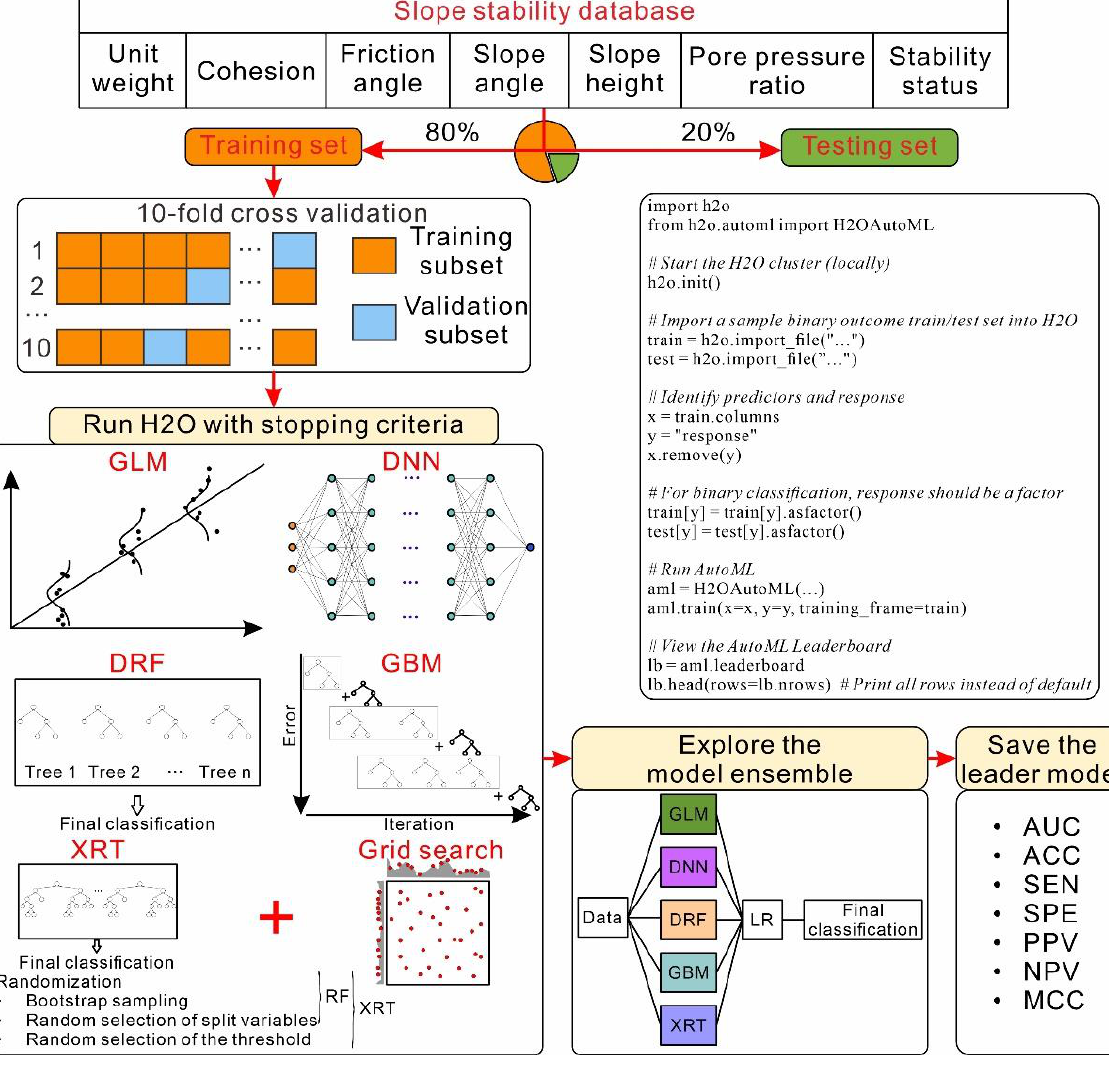
Figure 6. Flowchart of the AutoML-based slope stability classification. Table 4. The hyperparameter search space for GS optimization for AutoML-based slope stability classification.